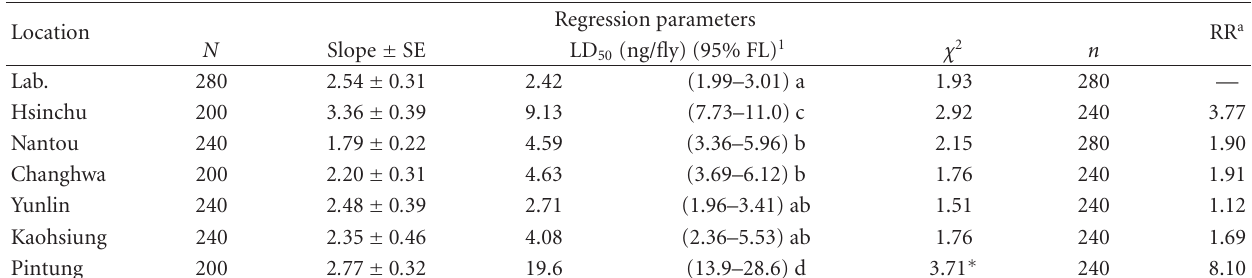
the probit analysis. 1 The RR is given as the values of LD 50 ofwildpopulation /LD 50 oflaboratorystrain to spinosad for the indicated post treatment time points. 2 Within the LD column, di ff erent letters after the parentheses indicate significantly di ff erent LD 50 values, as 95% FL did not overlap. Table 3: Susceptibility of field populations of B. cucurbitae (collected during 2007) to spinosad by topical application at 24h after treatment in